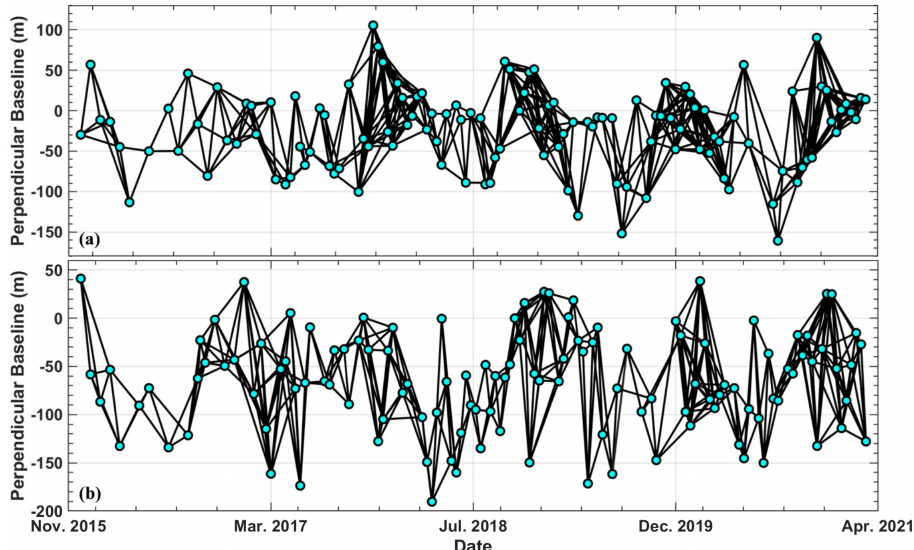
Figure 5. Spatiotemporal baseline information for ascending ( a ) and descending ( b ) Sentinel-1 images. The lines indicate the interferometric pairs, and the circles show SAR